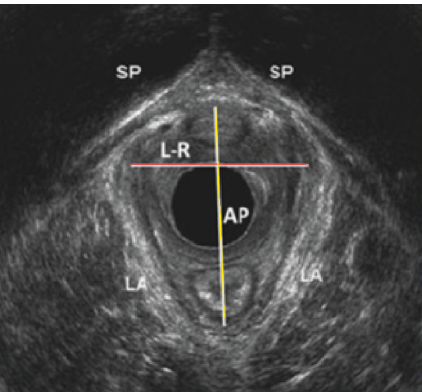
Figure 1: An Hiatus biometry measurement on 3D endovaginal ultrasound, intact levator ani muscle. AP, anteroposterior; L-R, left- to-right width; SP, symphysis pubis; LA, levator